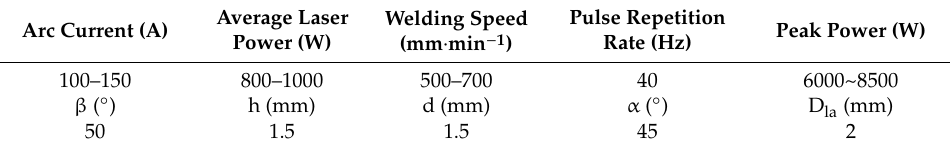
Figure 2. Laser induced arc hybrid welding process and the schematic diagram. Table 3. Main parameters of laser induced arc welding Al alloy processes.